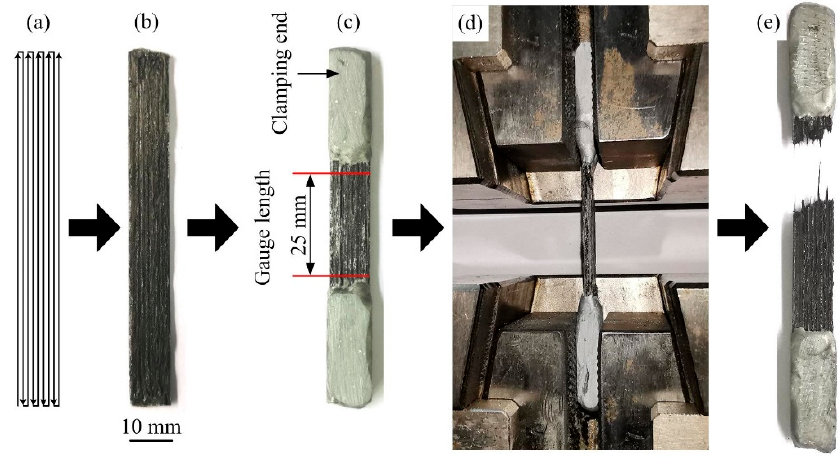
Figure 8. Composite tensile specimen entity and its tensile process. ( a ) S-shaped forming path along the long side; ( b ) the original tensile sample; ( c ) both ends of the prepared tensile specimen were coated with strong foundry glue; ( d ) sample clamping and stretching; ( e ) the specimen after being pulled.